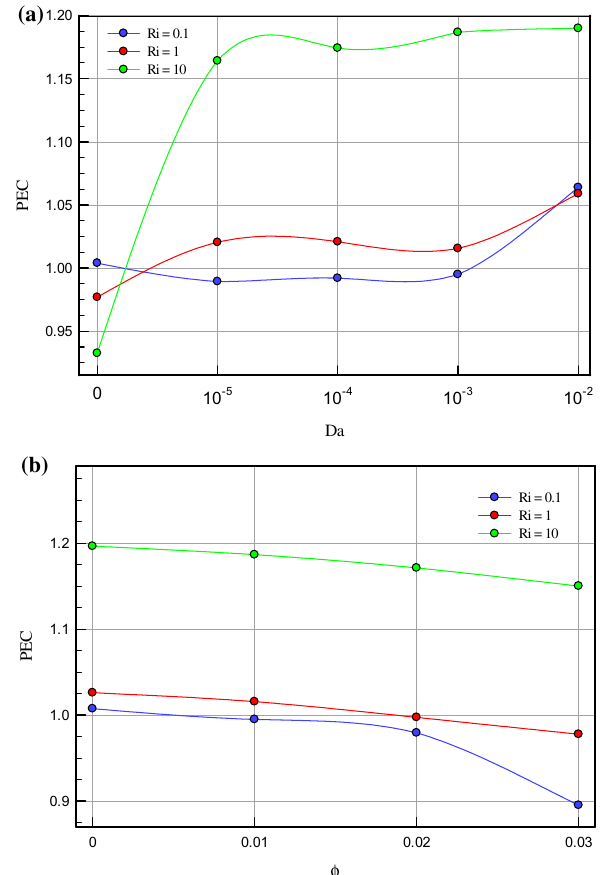
Figure 9. ( a ) Effect of different Darcy number on PEC for τ = 0.1, fraction of nanoparticles on PEC for τ = 0.1, Da = 10 –3 , ɛ =